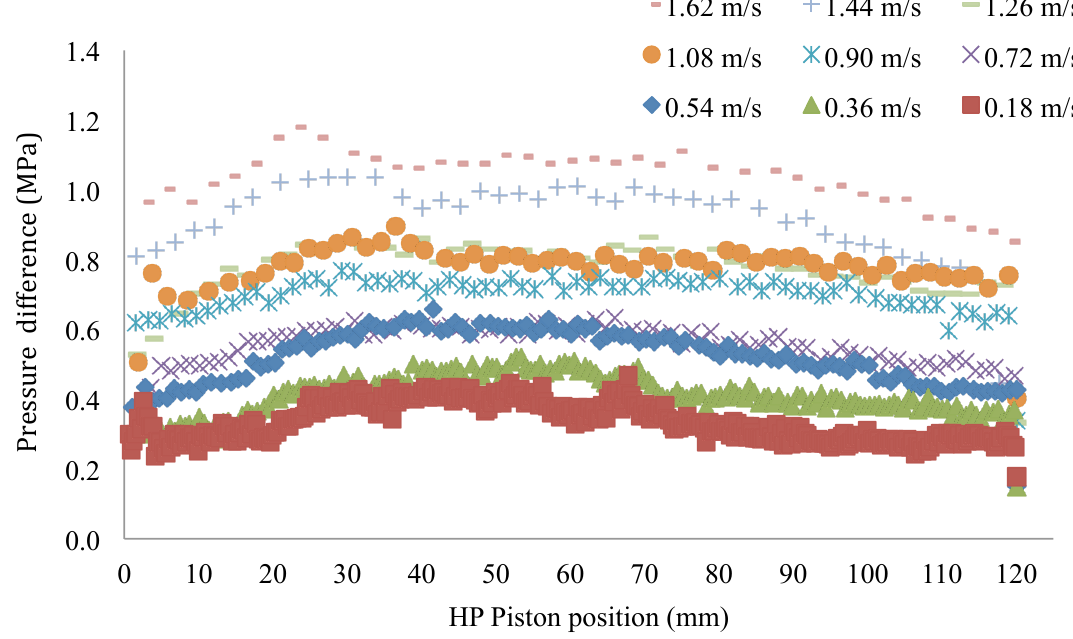
Figure 10. The pressure difference through the ERF valve at various flow velocities without the E-field is